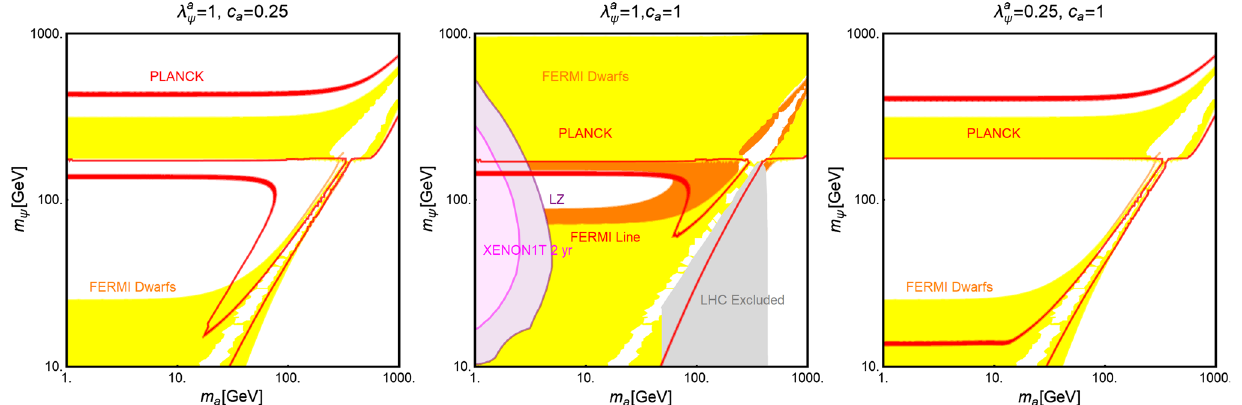
limit given by FERMI from searches of signals in dSphs [105]. In the orange regions the loop-induced annihilation cross-section into pho- ton lines exceeds limits set by searches of gamma-ray lines [102]. For (λ a , c ) = ( 1 , 1 ) an exclusion region (grey) from the LHC searches a ψ of monojet events [133], as well as projected exclusion regions from XENON1T (magenta) and LZ (purple) are also